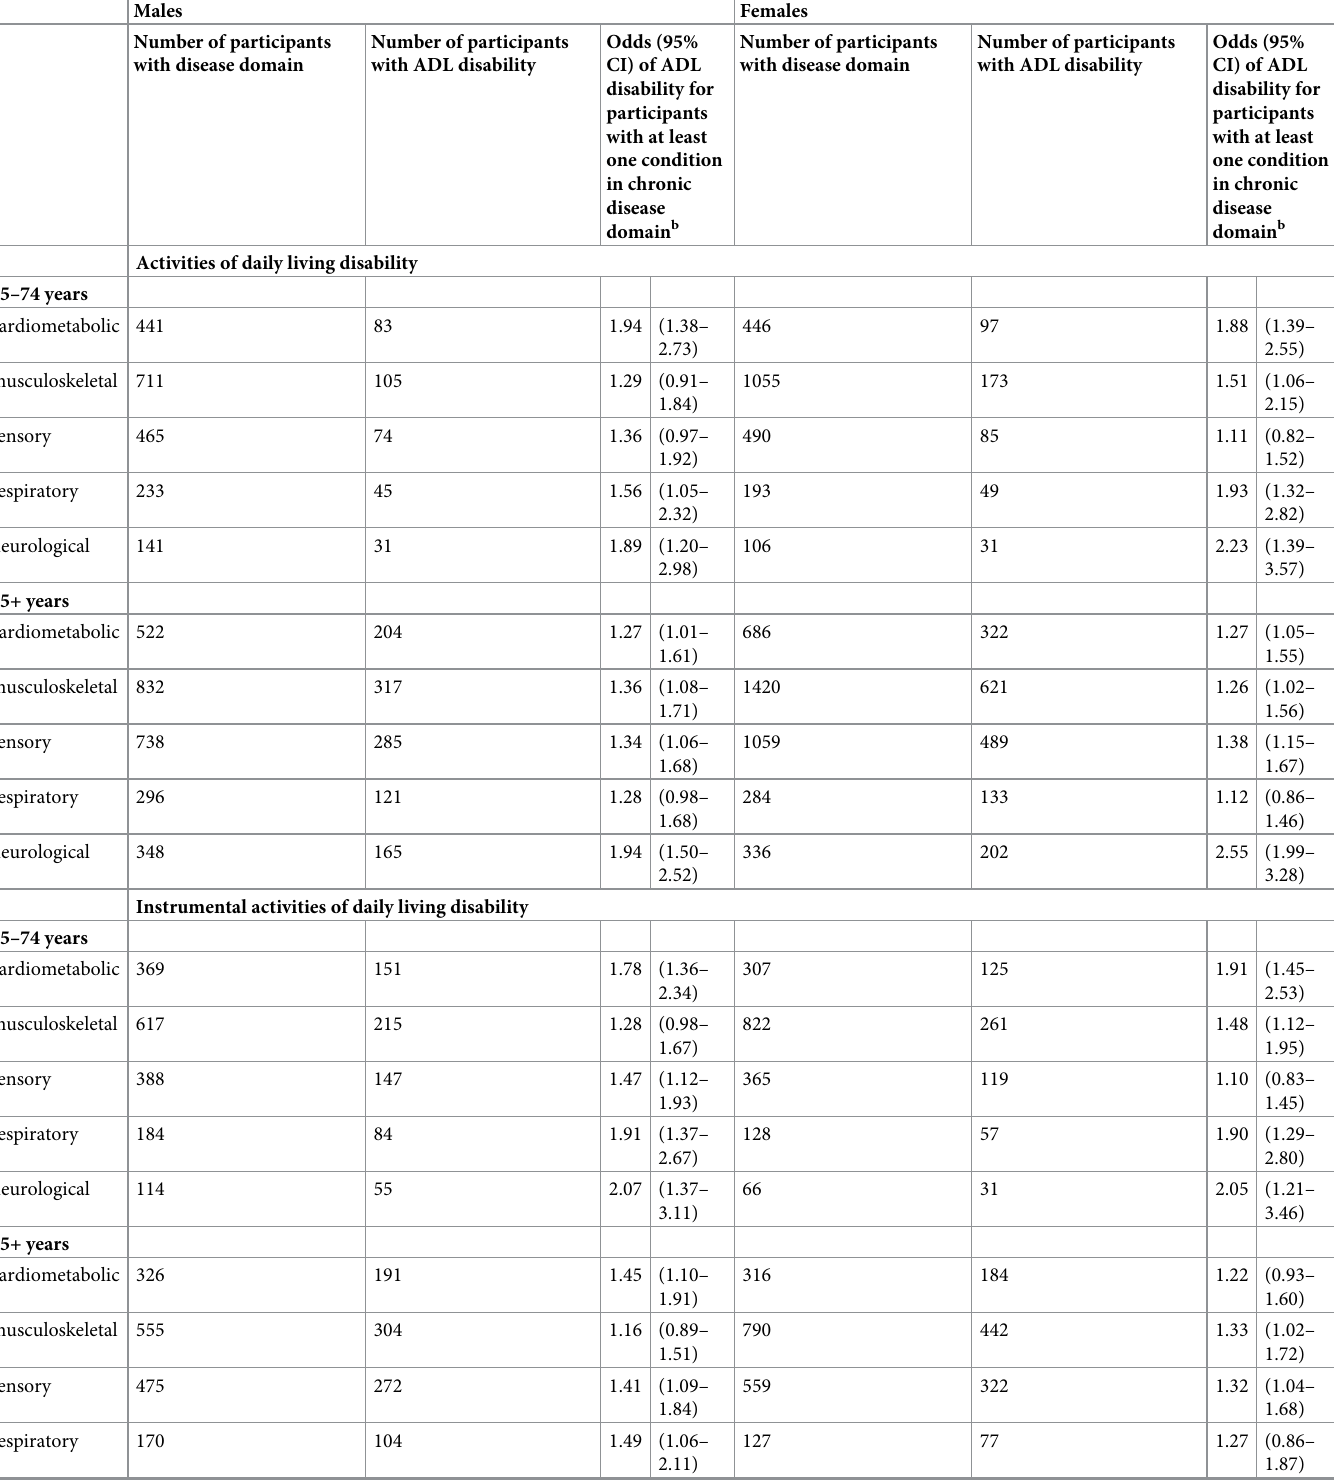
Table 3. Odds of activities of daily living disability and instrumental activities of daily living disability for participants with at least one condition in chronic disease domain after five years of follow up, stratified by age and sex a